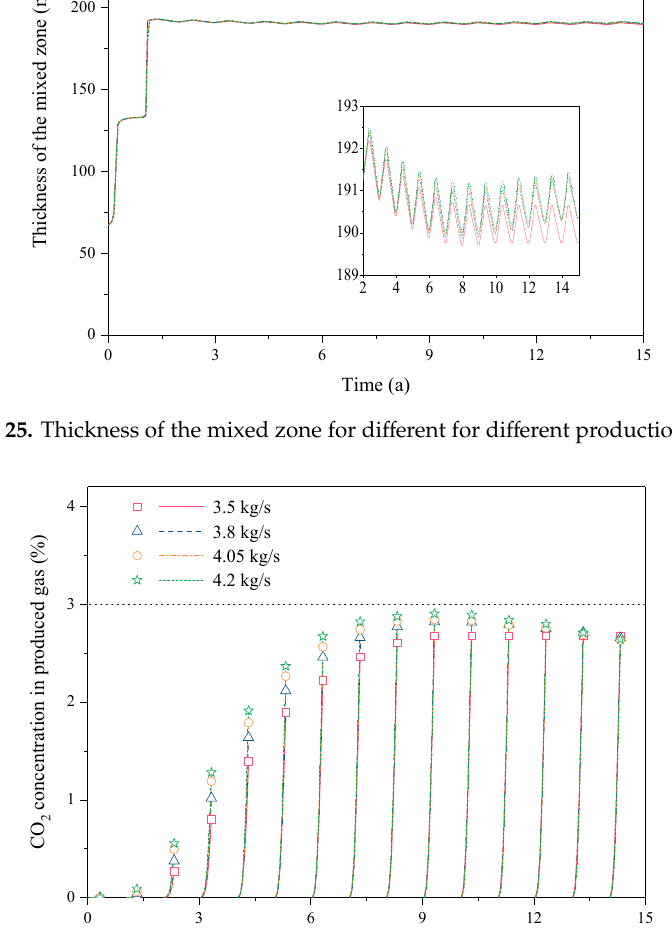
Figure 26. CO 2 concentration in the produced gas for different production rates.